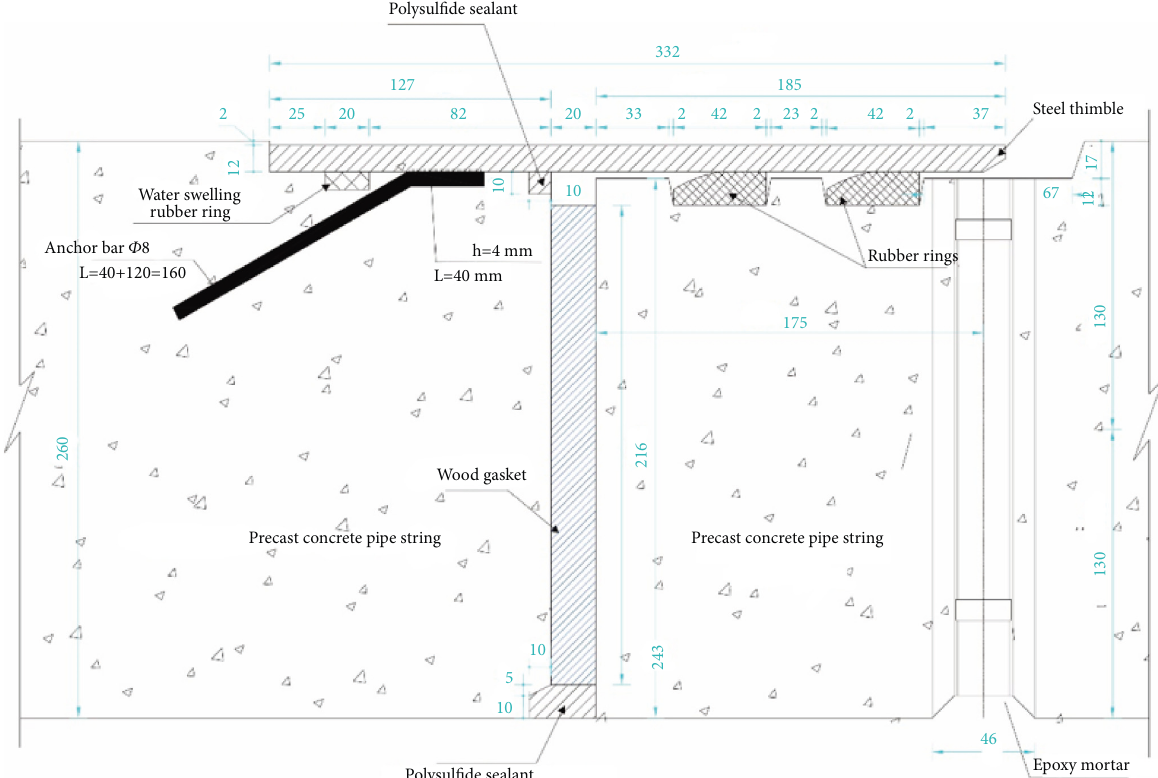
Figure 1: Structural design of pipe string joint.